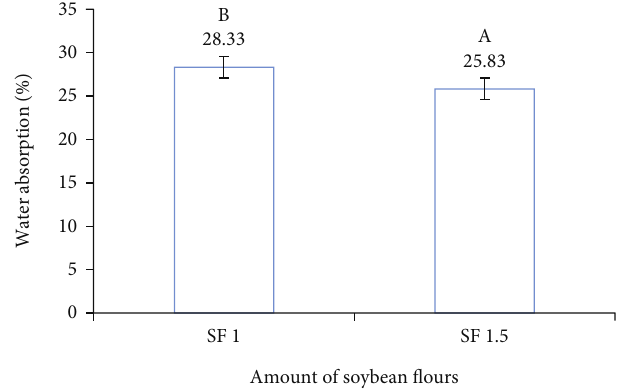
Figure 4: The e ff ect of weight ratio of soybean fl our to bagasse (SF1) and (SF1.5) on the water absorption of the biofoam cup (values followed by the same letter indicate nonsigni fi cant di ff erences).